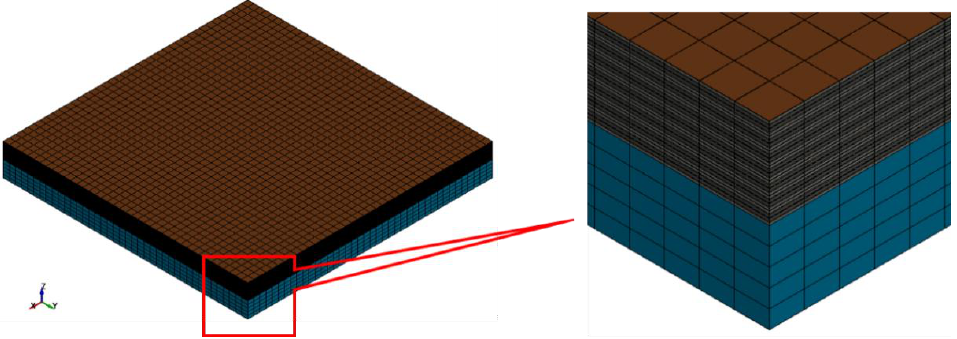
Figure 7. A battery cell model with a hybrid modelling technique.